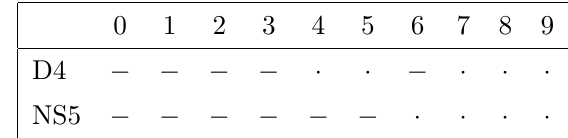
Figure 3 . IIA picture of a 4d N = 2 necklace quiver with n SU( N c ) gauge groups: n stacks of N c D4-branes suspended between n distinct